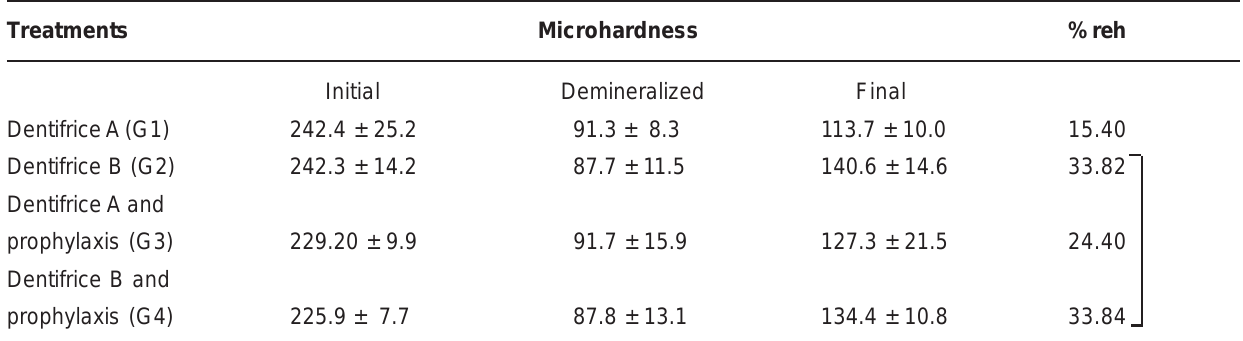
Groups connected by bars (G2 and G4) did not present statistically significant difference (Student-Newman-Keuls test ; p <